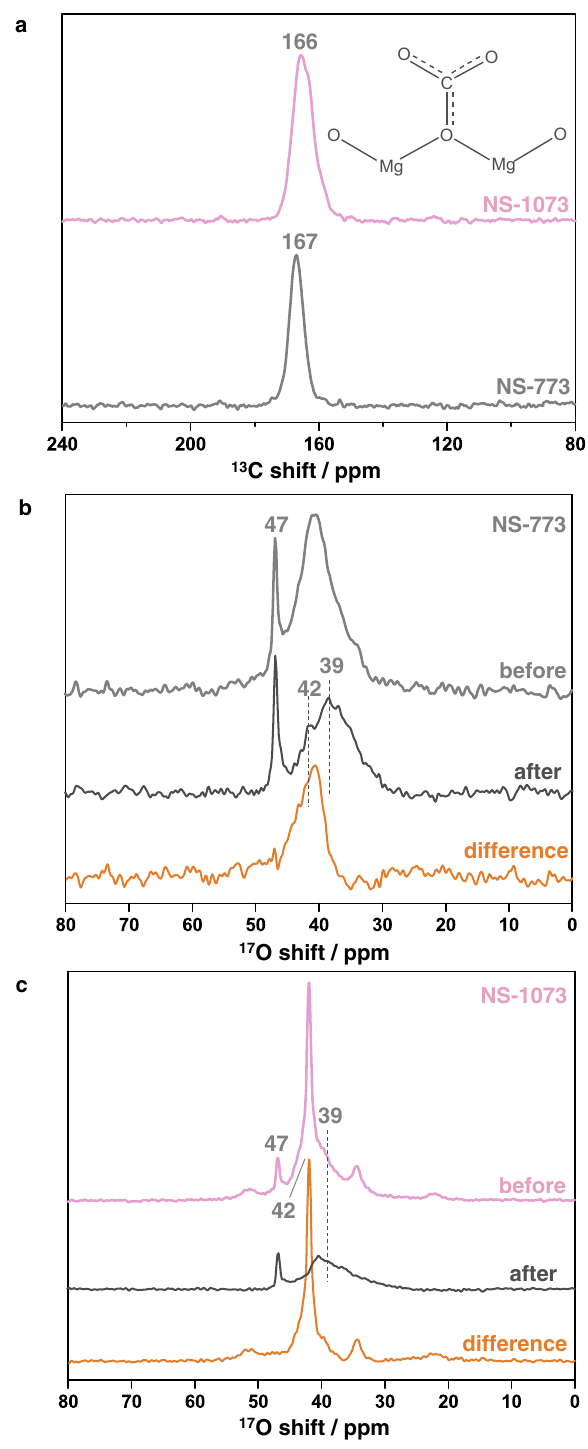
Fig. 2 13 C and 17 O single-pulse MAS NMR data of MgO nanosheets adsorbed with CO 2 . a Single-pulse 13 C MAS NMR spectra of NS-773 and NS-1073 after 13 CO 2 chemisorption at 9.4 T. MAS rate: 16 kHz; recycle delay: 40 s. 17 O NMR spectra of NS-773 ( b ) and NS-1073 ( c ) before